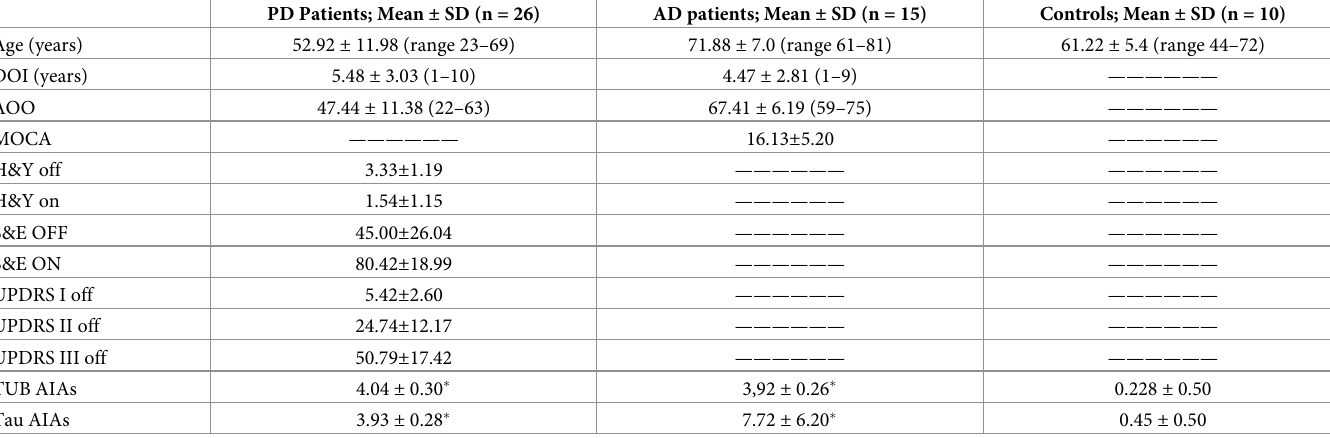
Table 1. Demographic, clinical and serum autoantibodies of patients with PD and AD diseases. PD Patients; Mean ± SD (n =